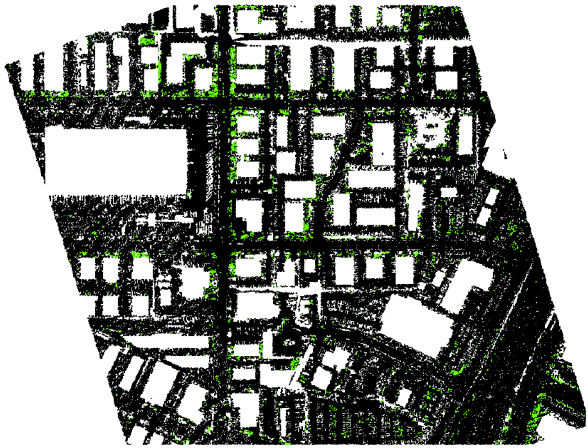
Figure 6. Classification of DTM points into grass and asphalted regions.